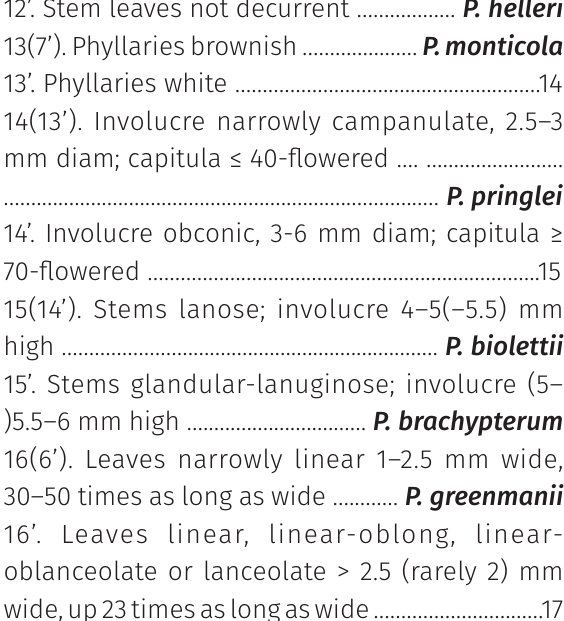
12’. Stem leaves not decurrent ……………… P.